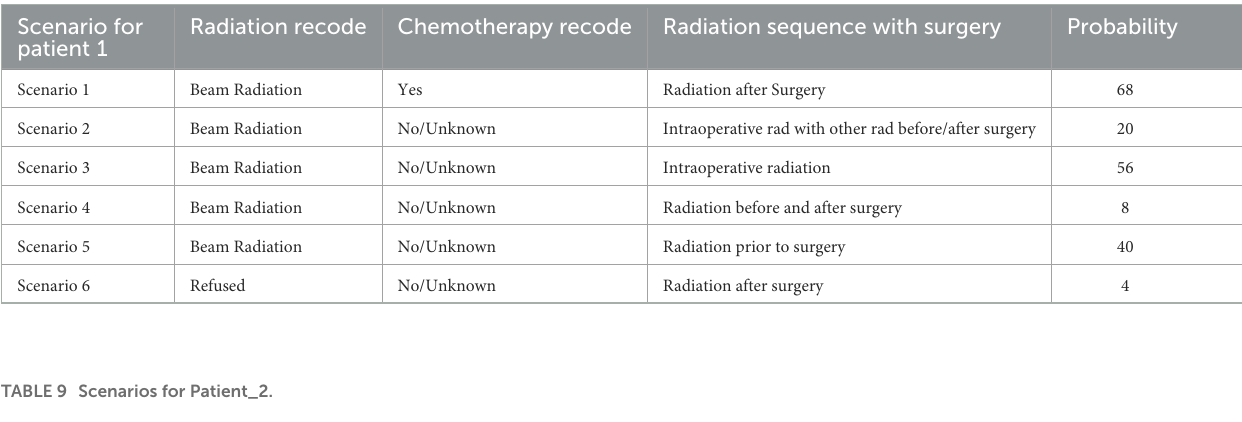
TABLE 8 Scenarios for Patient_1.